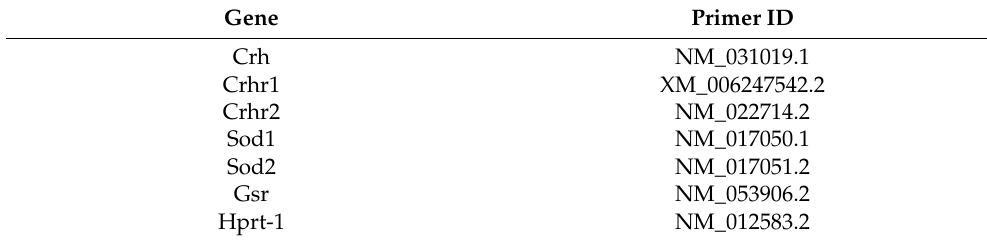
Table 1. List of primers used for